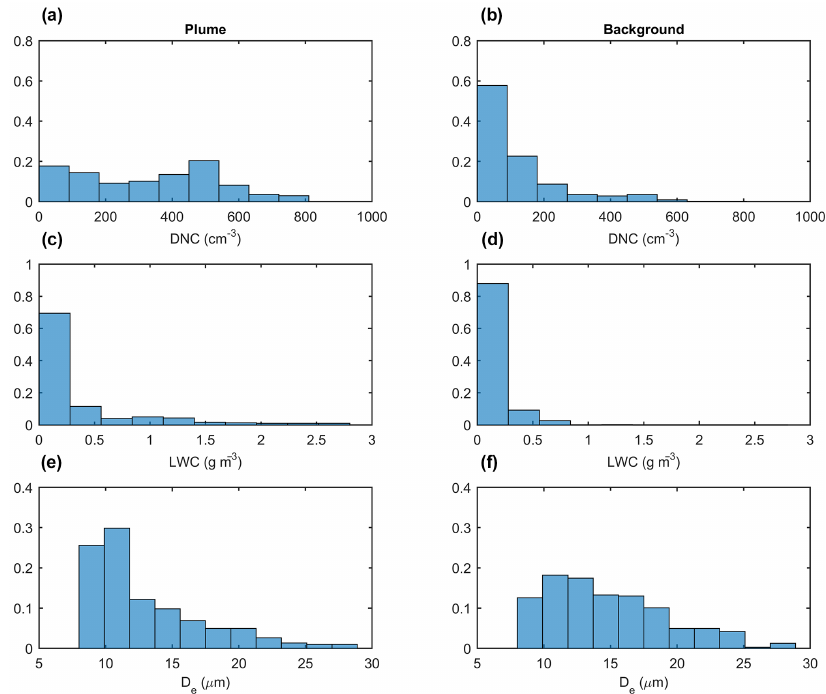
Figure 6. Normalized histograms of cloud droplet properties affected and unaffected by the Manaus plume. (a – b) Total droplet number concentration (cm − 3 ) , (c – d) liquid water content (gm − 3 ) , and (e – f) effective diameter